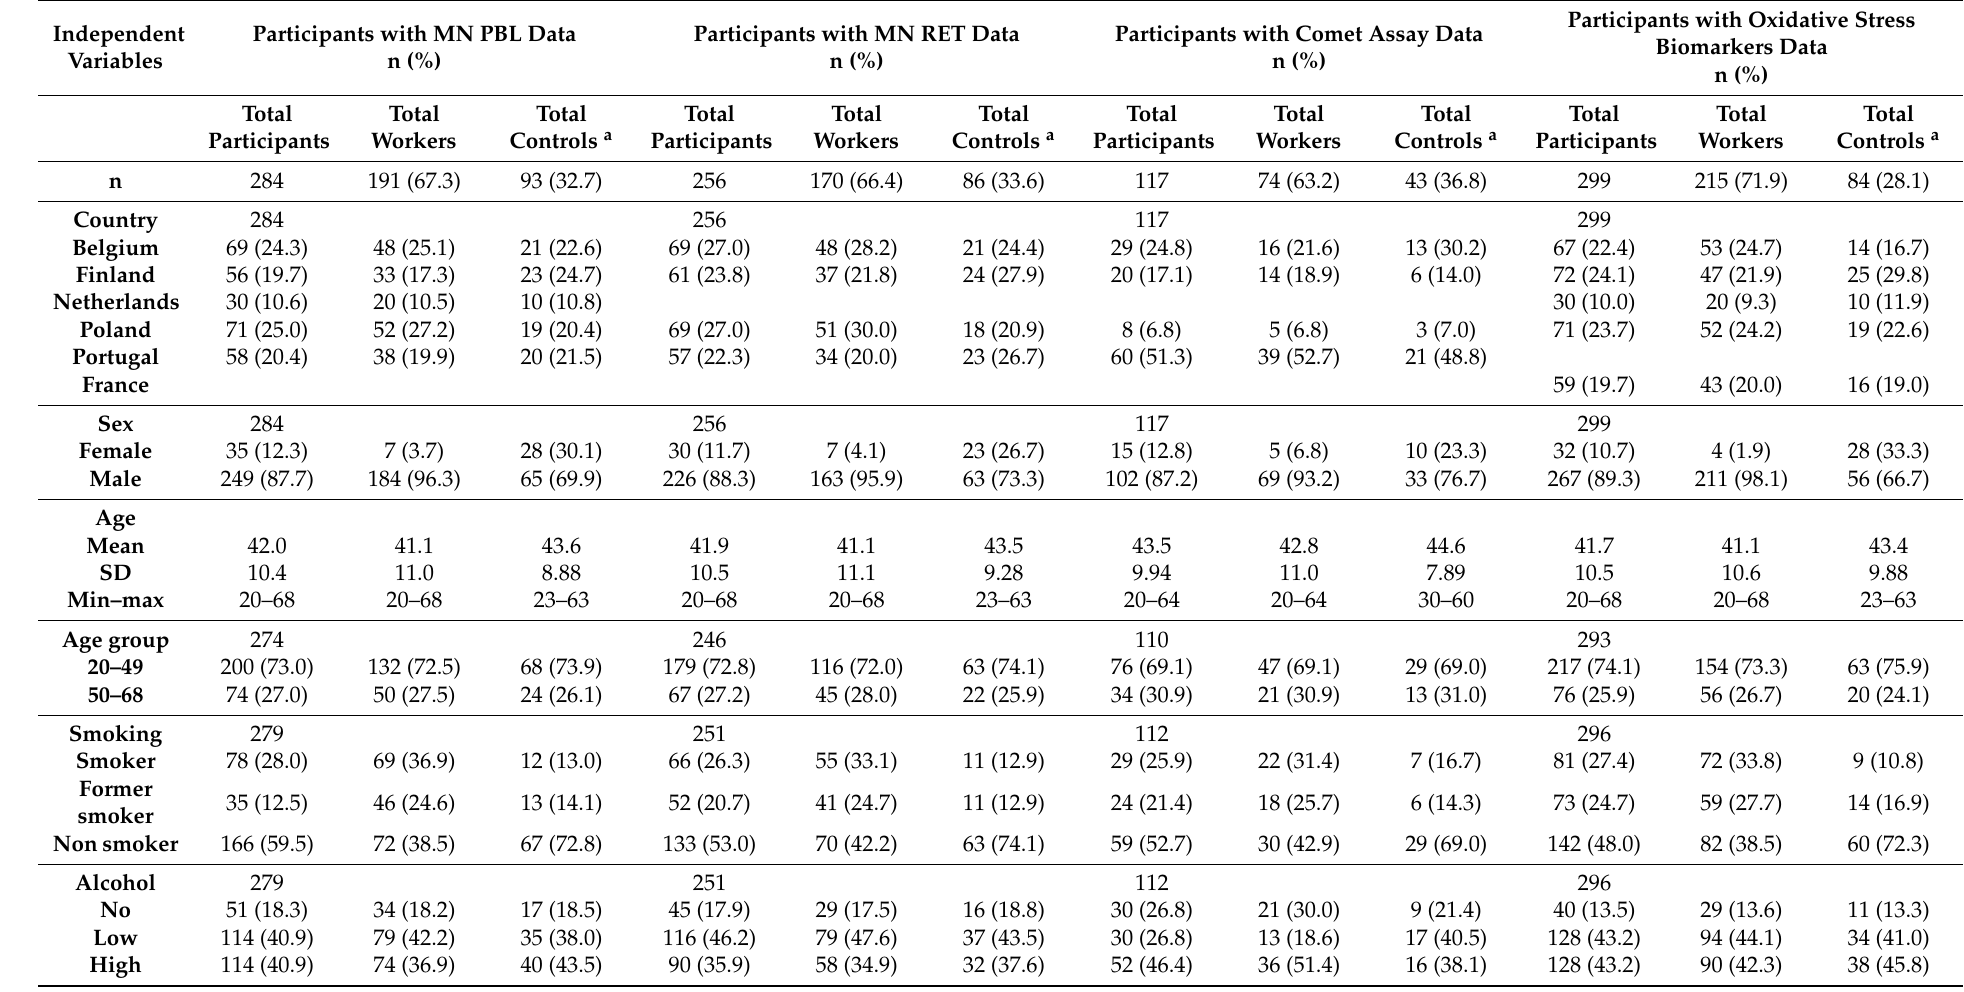
Table 1. Participants’ distribution among the exposure groups (workers/controls) according to their main